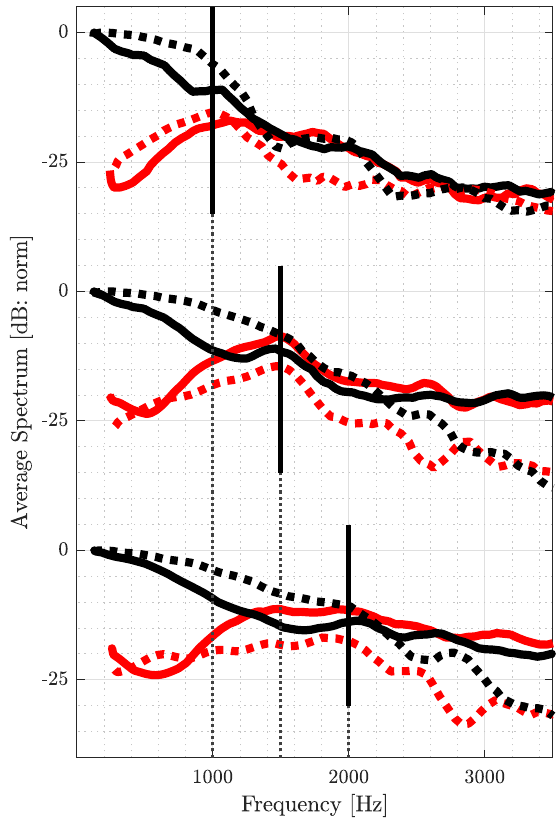
Figure 5. Comparison between measured (solid) and simulated (dashed) external spectra in a decibel representation for three resonators with cutoffs f c = 1.0, 1.5, 2.0 kHz at forte playing conditions. Odd harmonics are depicted in black and even harmonics in red. Synthesis control parameters provided in Section